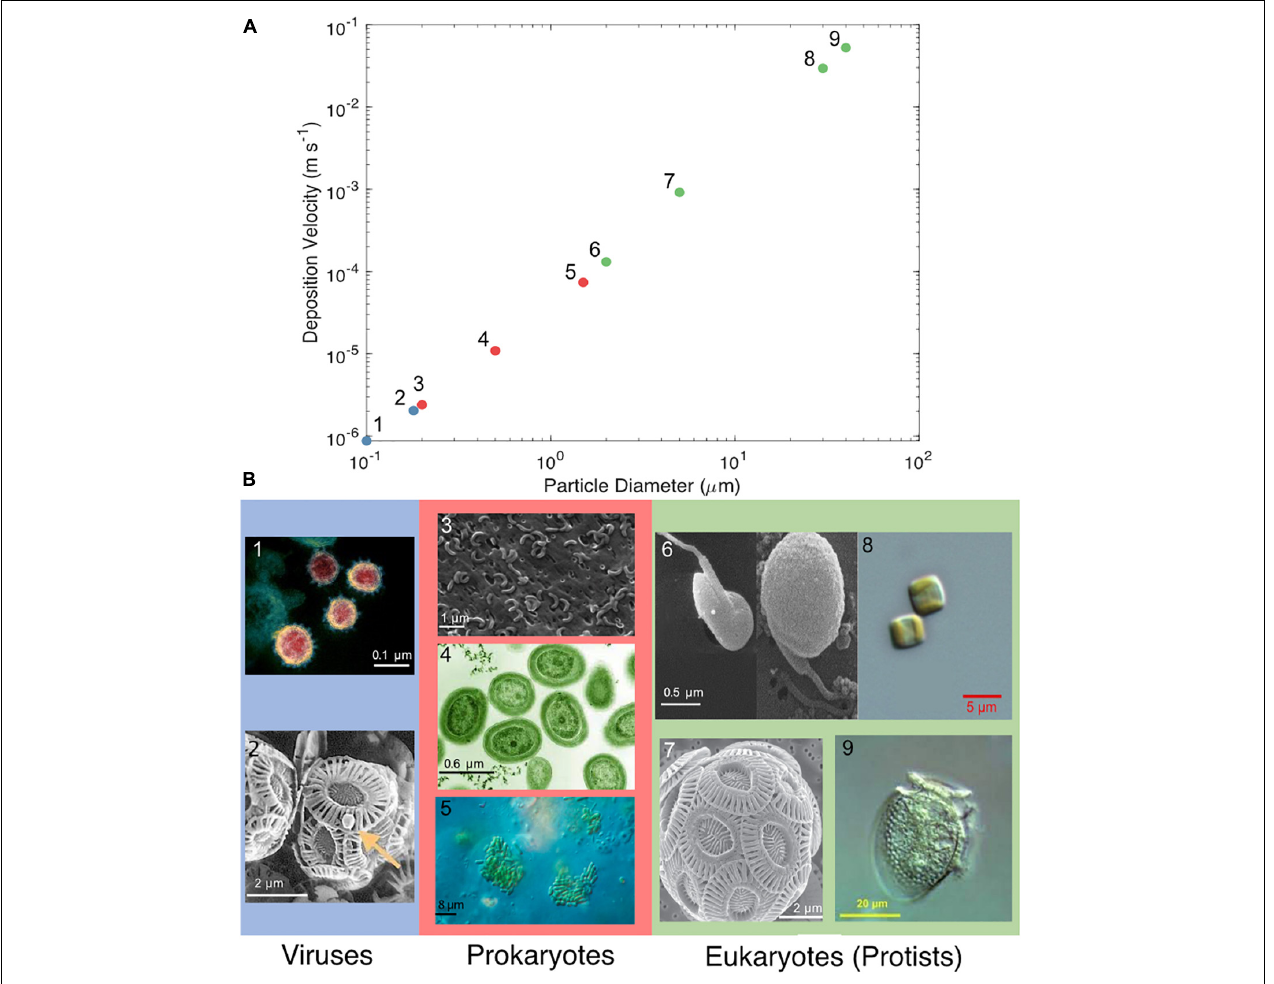
FIGURE 1 | (A) Deposition velocity of varying cell diameters of viruses (blue), prokaryotes (red), and eukaryotes (green). (B) Microscopy images of microorganisms representative of the particle diameter chosen: (1) SARS-CoV-2, (2) Emiliania huxleyi virus, (3) SAR11, (4) Prochlorococcus , (5) Synechococcus , (6) Micromonas pusilla , (7) Emiliania huxleyi , (8) Thalassiosira sp., and (9) Dinophysis acuminata . (1–7) Approximate scale bars were added. The microscopy images in (B) were reproduced under the Creative Commons Attribution International licenses and were captured by (1) NIAID’s Rocky Mountain Laboratories in Hamilton, Montana (2) Wikimedia commons (3) Steindler et al. (2011) (4) Luke Thompson at the Sallie Chisholm Lab and Nikki Watson at Whitehead, MIT (5) Proyecto Agua at Biodiversidad virtual, Cantabria, Spain (6) Manton and Parke (1960) and courtesy of Nordic Microalgae and Aquatic Protozoa (Karlson et al., 2020) (7) Alison R. Taylor, University of North Carolina Wilmington Microscopy Facility (8) Moore et al. (2017) and (9) Plankton Net, Alfred Wegener Institute, Helmholtz Centre for Polar and Marine